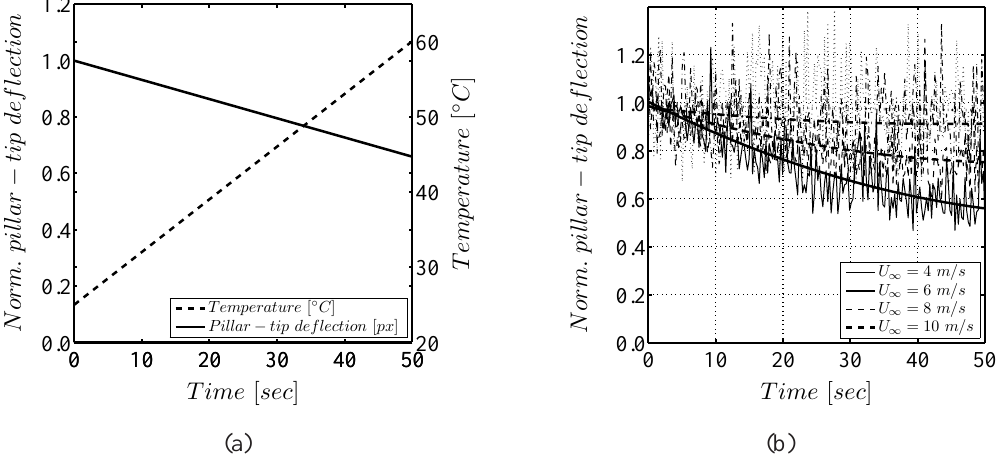
Figure 8. ( a ) Temperature dependence of the pillar-tip deflection in plate-cone rheometer flow at constant rotation. Temperature increase due to illumination. ( b ) Pillar deflection in turbulent boundary layer flow at freestream velocities U ¥ = 4 , 6 , 8 and 10 m / s .